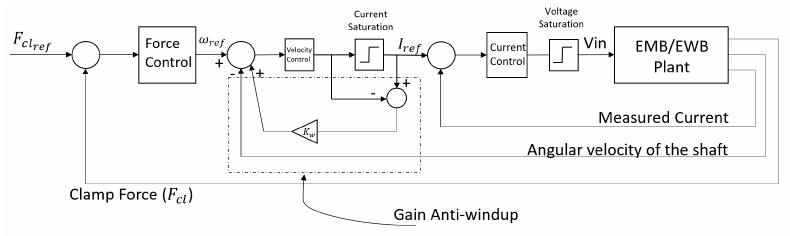
Figure 4. Anti-windup gain used to compensate for the current